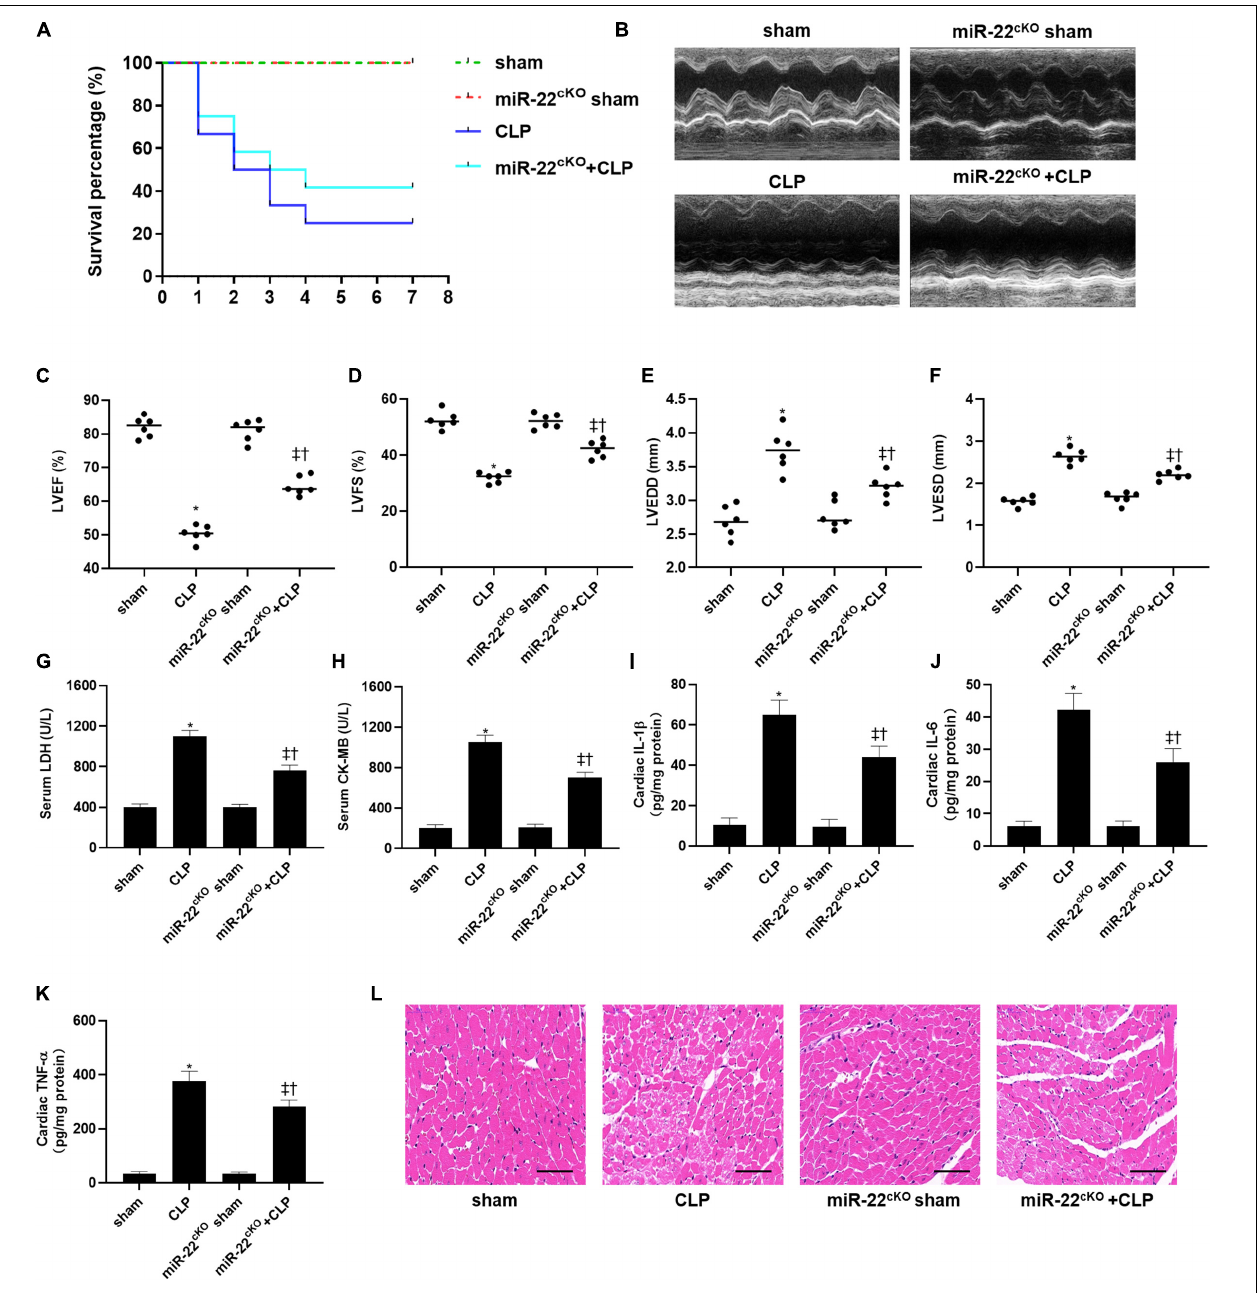
FIGURE 1 | Knocking out miR-22 alleviates cardiac dysfunction and increases the survival rate in CLP-induced cardiomyopathy. (A) survival curves. Mortality was observed for 7 days, 12 mice of each group was used for comparison; (B) M-mode Echocardiograms representative image ( n = 6); (C) LVEF; (D) LVFS; (E) LVESD; (F) LVEDD; (G) serum LDH ( n = 6); (H) serum CK-MB ( n = 6); (I) cardiac IL-1 β ( n = 6); (J) cardiac IL-6 ( n = 6); (K) cardiac TNF α ( n = 6); (L) HE staining representative images. Scale bar = 25 µ m. Data were show as mean ± SEM. ∗ P < 0.05 vs. sham group; ‡ P < 0.05 vs. CLP group; † P < 0.05 vs. miR-22 cKO sham